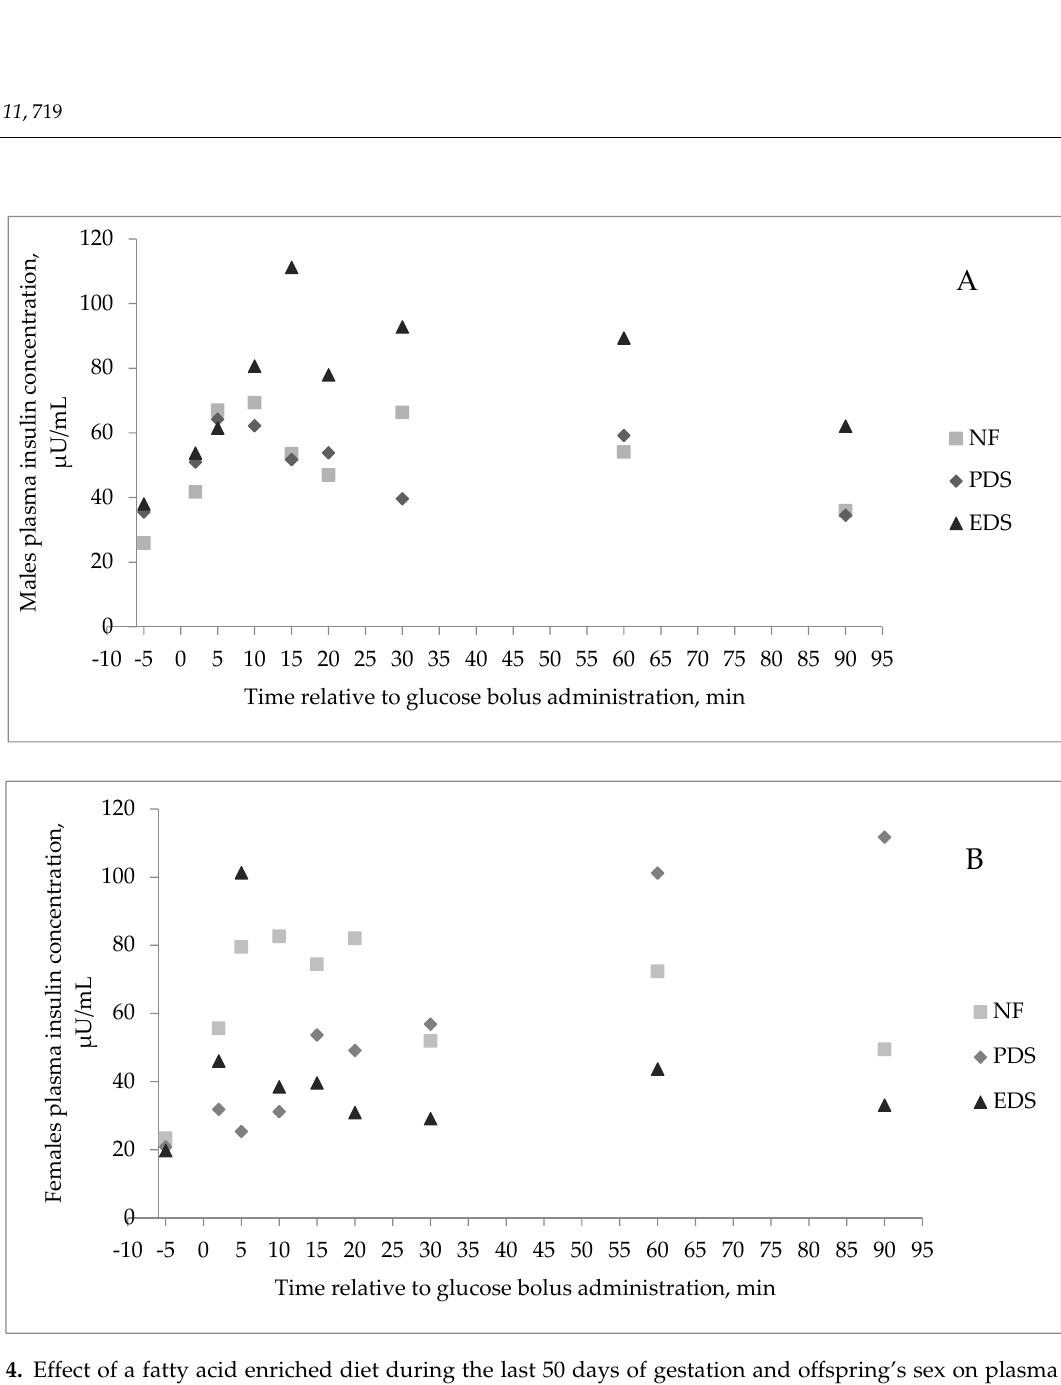
Figure 4. Effect of a fatty acid enriched diet during the last 50 days of gestation and offspring’s sex on plasma insulin concentration during the glucose tolerance test on offspring during the finishing period (18 lambs; 2 sex and 3 dam treatments; ( A ) is the response for male and the ( B ) is the response for females). Data are presented as the LSmean of Fatty acid supplementation × Time × Sex ( p = 0.08; standard error of the mean (SEM) = 20.03). No difference ( p ≥ 0.47) for FA, Time, Sex, FA × Time, and Time × Sex. Treatments of ewes supplemented with Ca salts of MUFA (PDS; EnerGII, Virtus Nutrition LLC, Corcoran, CA), PUFA (EDS; Strata G113, Virtus Nutrition LLC, Corcoran, CA), or no supplementation (NF) during the last 50 days of